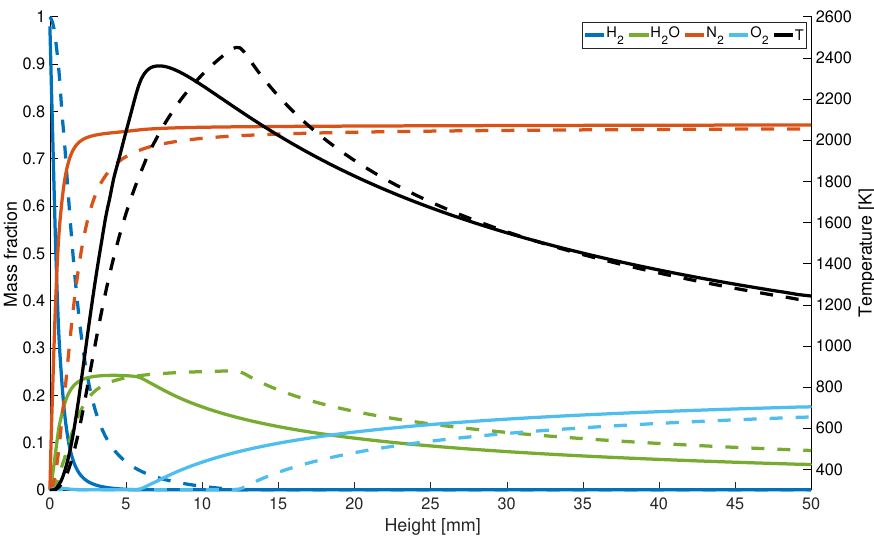
Figure 6. Axial temperature and mass fraction distribution; solid line: with differential diffusion, dashed line without differential